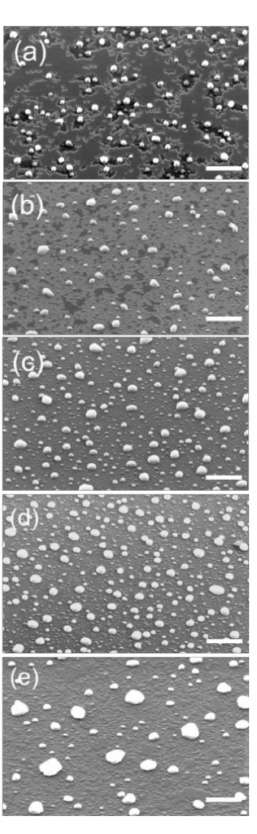
Figure 1. Scanning electron microscopy (SEM) images, measured in 45 degrees tilted view of